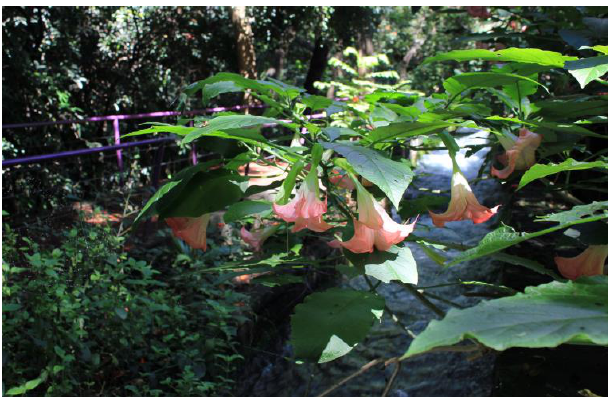
Figure 1. Brugmansia suaveolens .